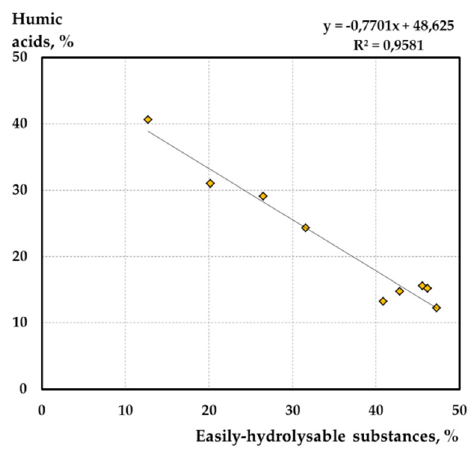
Figure 8. Dependence of humic acids content on easily-hydrolysable substances content of studied peat samples.